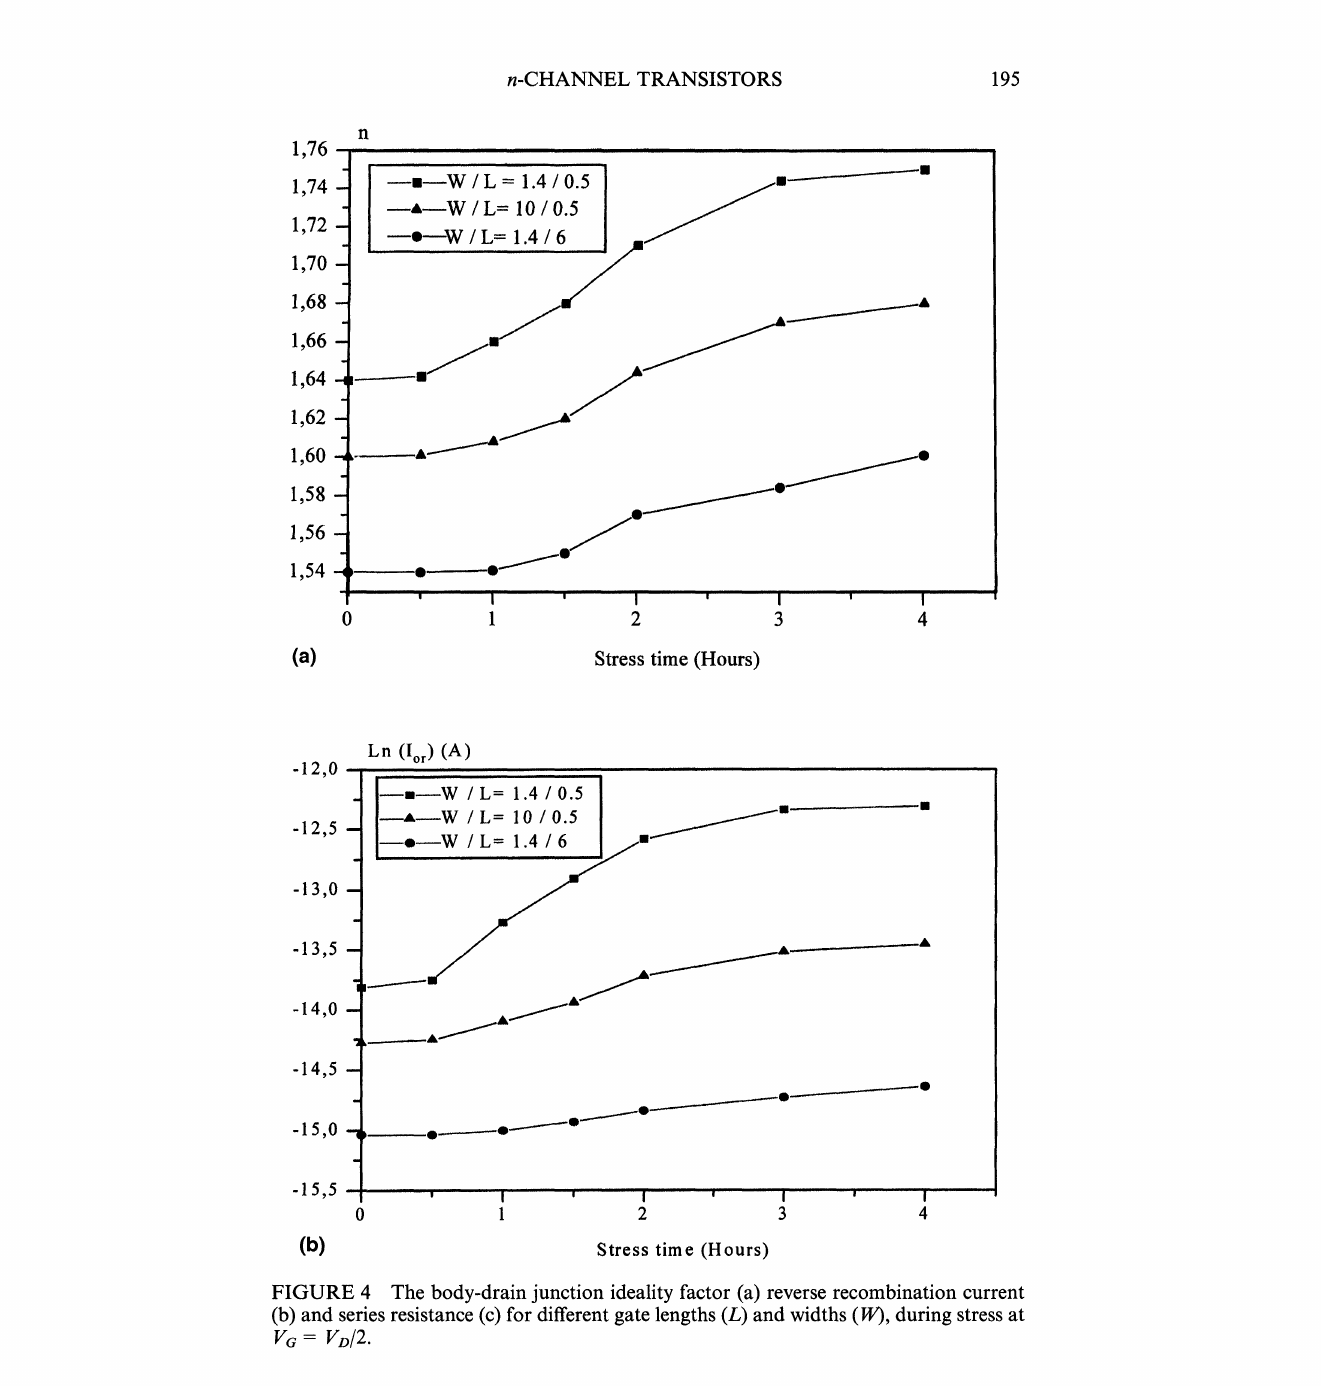
FIGURE 4 The body-drain junction ideality factor (a) reverse recombination current (b) and series resistance (c) for different gate lengths (L) and widths (gO, during stress at v